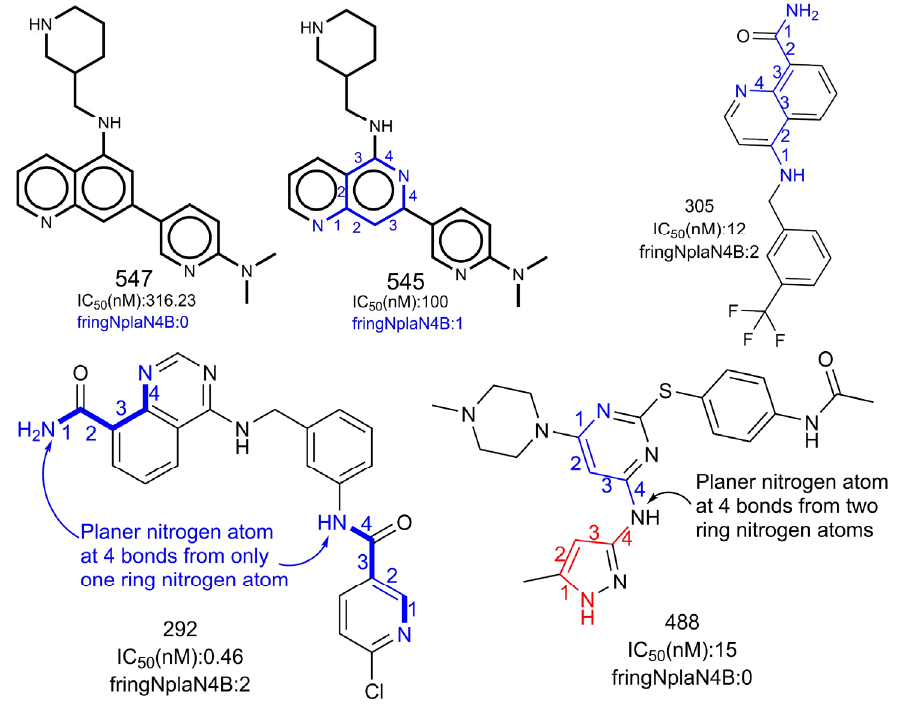
Figure 4. Representation of influence of fringNplaN4B on activity profile of AKB inhibitors. The numbers (blue/red) indicate the counting of number of bonds between ring and planer nitrogen.